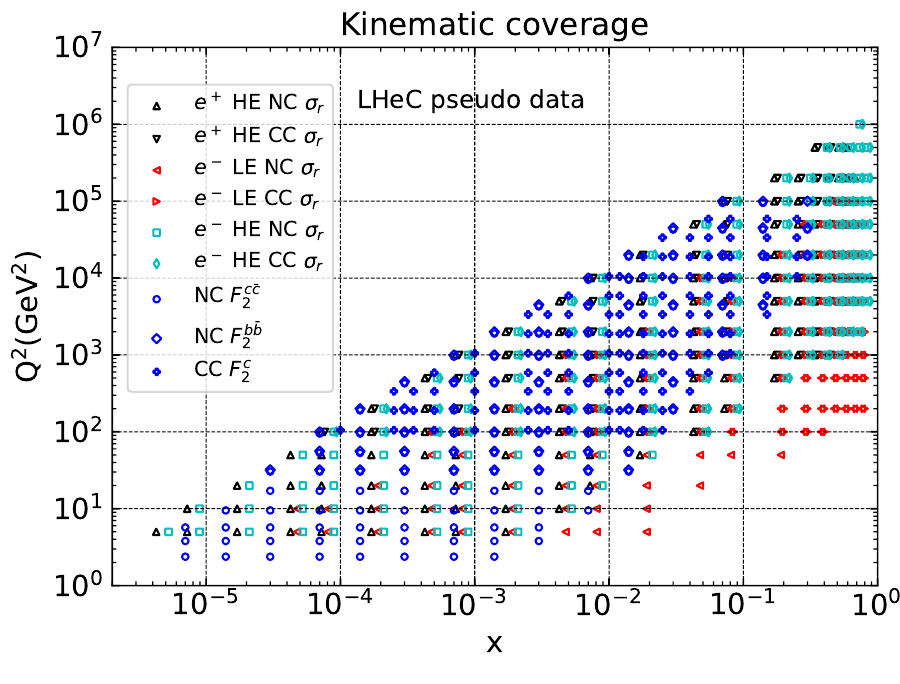
Figure 2.1: The kinematic coverage in the ( x , Q 2 ) plane of the LHeC pseudo–data [ 26, 27 ] included in the present analysis: the inclusive NC and CC structure functions both for high energy (HE) and low energy (LE) datasets, the NC charm and bottom semi- inclusive structure functions F c ¯ c and F b ¯ b , and the CC charm structure functions F c 2 2 providing direct information on the strange content of the